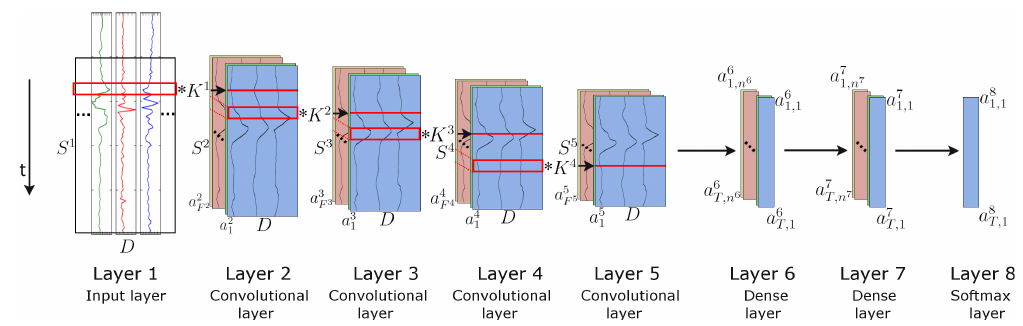
Figure 3. Architecture of the DeepConvLSTM (Conv, convolutional) framework for activity recognition. From the left, the signals coming from the wearable sensors are processed by four convolutional layers, which allow learning features from the data. Two dense layers then perform a non-linear transformation, which yields the classification outcome with a softmax logistic regression output layer on the right. Input at Layer 1 corresponds to sensor data of size D ˆ S 1 , where D denotes the number of sensor channels and S l the length of features maps in layer l . Layers 2–5 are convolutional layers. K l denotes the kernels in layer l (depicted as red squares). F l denotes the number of feature maps in layer l . In convolutional layers, a l denotes the activation that defines the feature map i in layer l . Layers 6 i and 7 are dense layers. In dense layers, a l denotes the activation of the unit i in hidden layer l at time t , i t . The time axis is